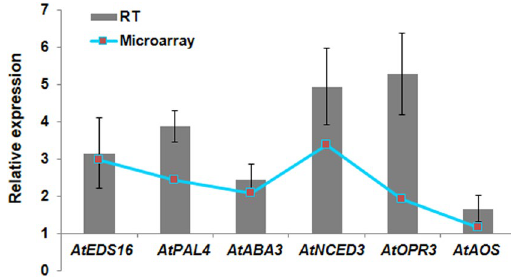
Figure 3. Validation of transcript expression pattern by RT-qPCR. Transcript expression profile of key genes involved in hormone biosynthesis obtained from microarray experiment was validated by RT-qPCR. Graph represents relative expression of the genes under combined DH stress. Bar and line graphs represent expression profile obtained from RT-qPCR and microarray experiments respectively. In RT-qPCR experiment, AtActin2 was used as reference gene for data normalization. Fold change was calculated over mock control. Each bar represents average of four biological and two technical replicates ±